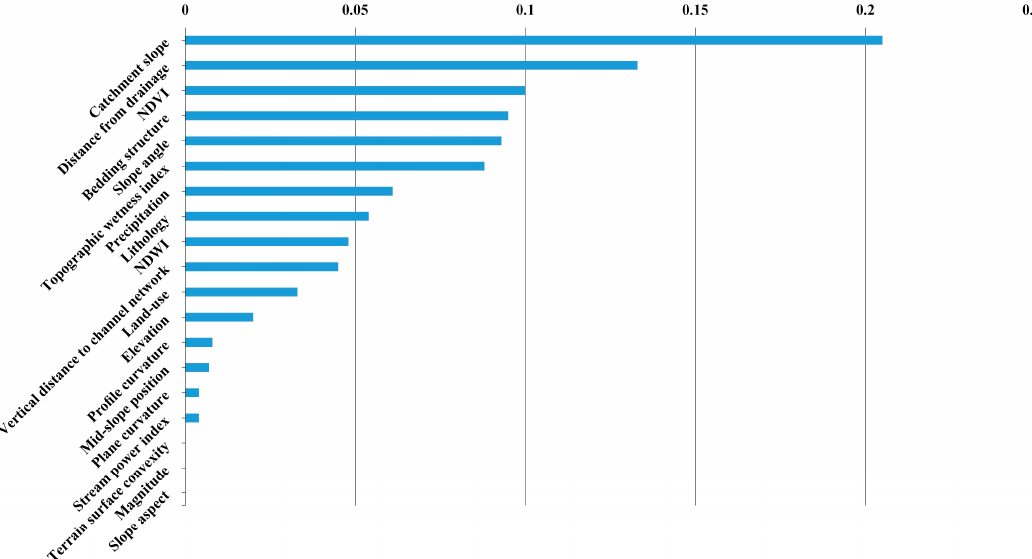
Figure 10. Importance values of the remaining 19 environmental factors.